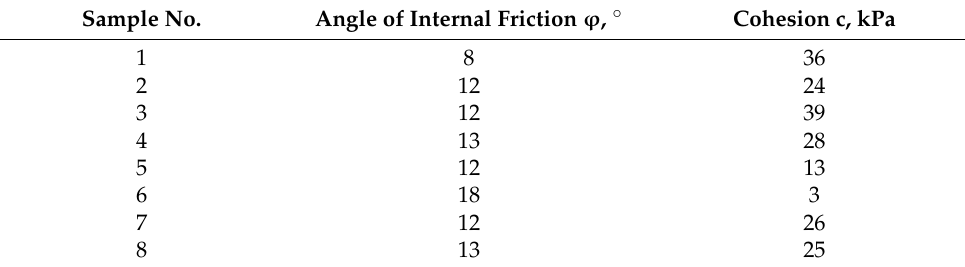
Table 2. Direct shear test